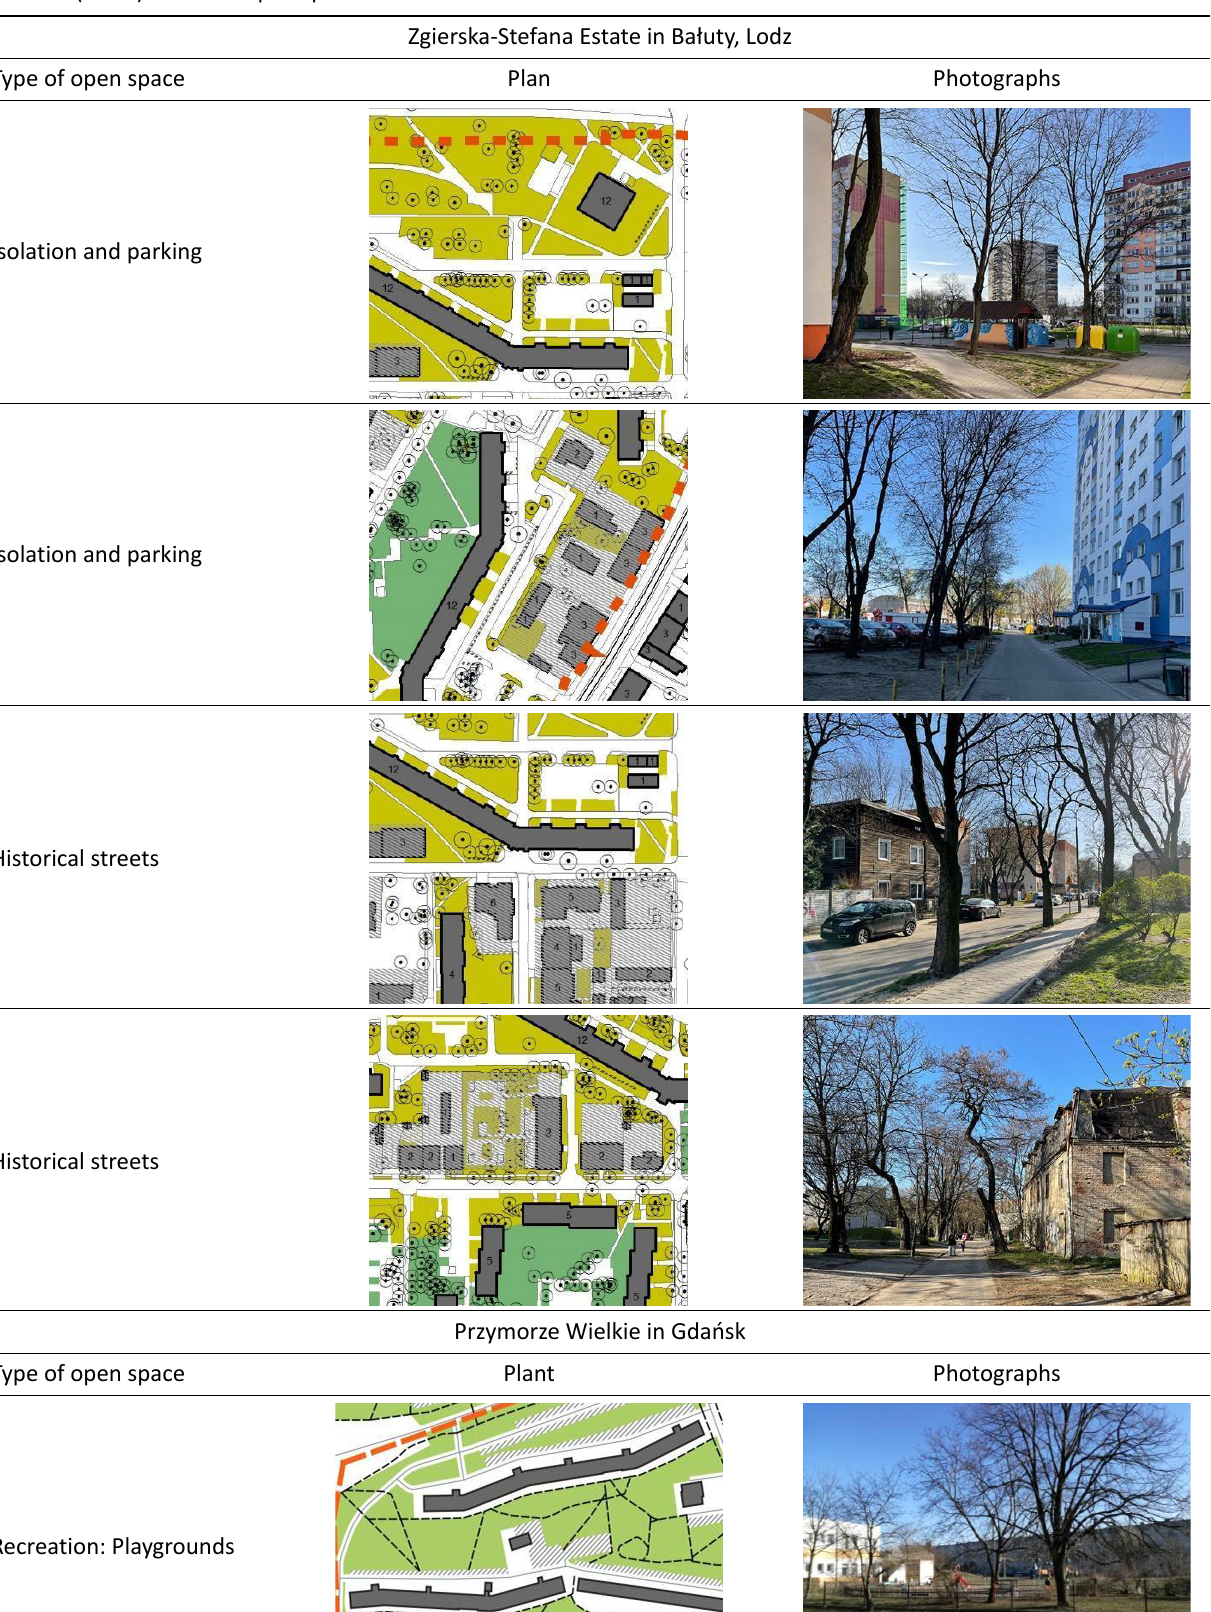
Table 3. (Cont.) Forms of open